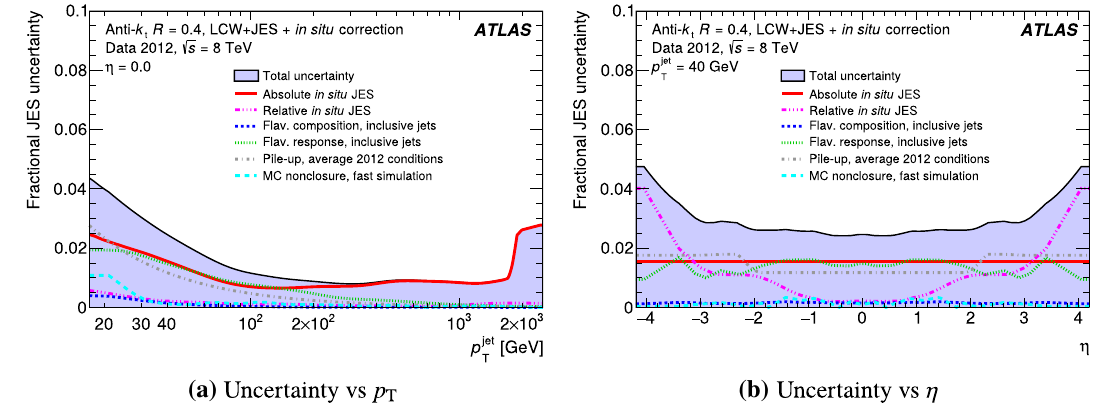
Fig. 43 Total uncertainty in the calibration of anti- k t , R = 0 . 4 jets in fast simulation as a function of p T and η . “Absolute in situ JES” refers to the uncertainty arising from Z +jet, γ +jet, and multijet mea- surements. “Relative in situ JES” refers to the uncertainty arising from